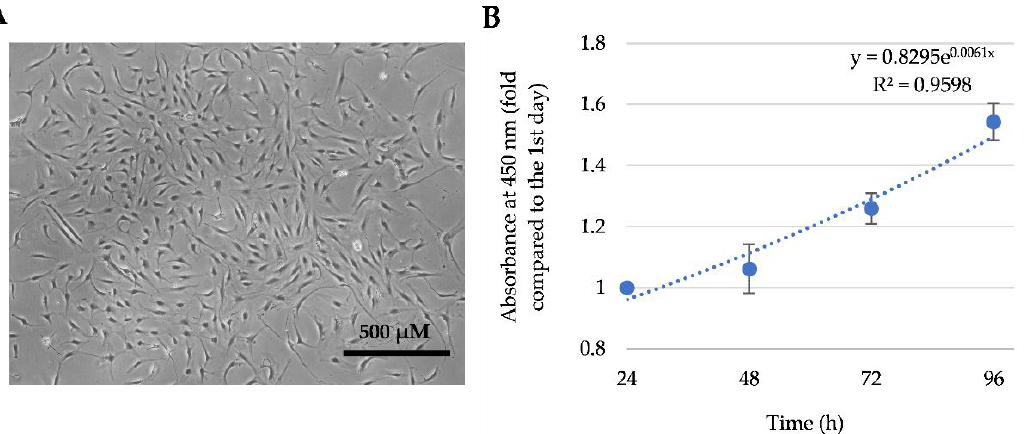
Figure 1. The identification of total SM-MSCs population isolated from human skeletal muscle. ( A ) morphology identified by light microscope; ( B ) proliferation of SM-MSCs. Data are shown as mean ± standard deviation (SD), n = 4 from three independent experiments calculated by an Excel pro- gram.